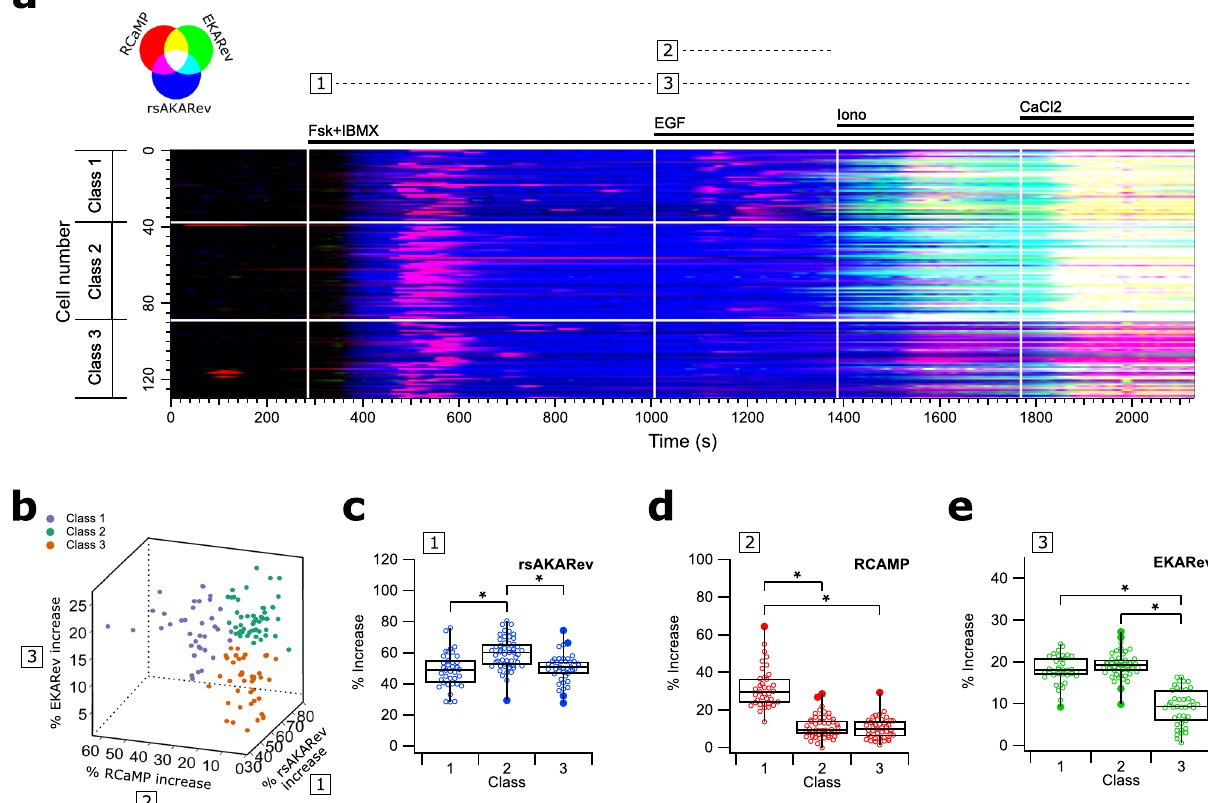
Fig. 6 Three-biosensor unmixing reveals heterogeneity in cellular responses. HEK293T cells simultaneously expressing rsAKARev, EKARev, and RCaMP biosensors. a RGB color-coded responses of RCaMP (red), EKARev (green), and rsAKARev (blue). b 3D scatter plot of the maximal response, colored by the clustering assignment of each cell. c – e Box-plots of the maximal response observed for rsAKARev ( c ), RCaMP ( d ), and EKARev ( e ) during indicated time intervals. The middle line is the median, lower and upper hinges represent fi rst and third quartile, whiskers extend to the full width of the data, outliers (further than 1.5× the interquartile range from the hinges) are represented by fi lled circles. n = 129 cells from 1 experiment with 37, 51, 41 cells in classes 1, 2, 3. Two-tailed unpaired Student ’ s t -test ( c , e {1,3}), Welch ’ s unequal variance test ( e {2,3}), Mann – Whitney U test ( d ); values between brackets indicate the compared classes. “ * ” indicates signi fi cant differences ( p < 0.0001); all other differences are non-signi fi cant ( p > 0.05). Cells were stimulated